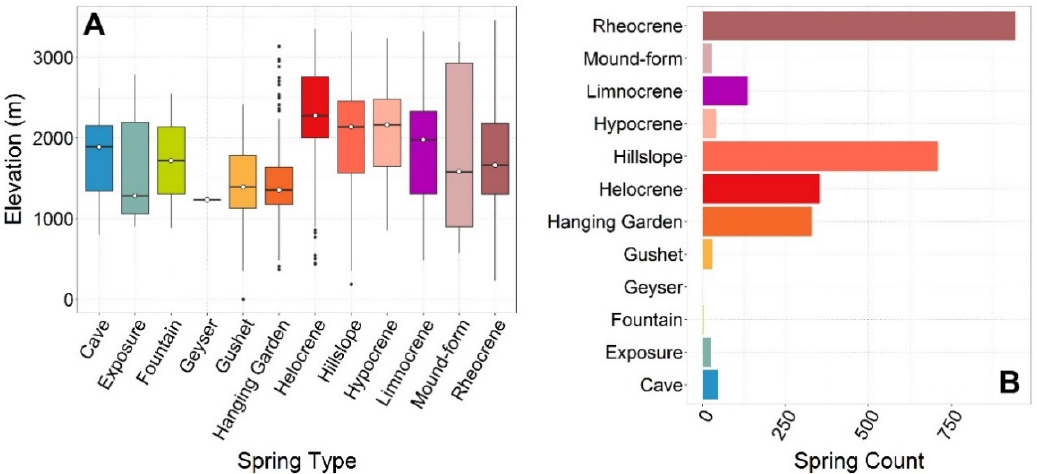
Figure 3. ( A ) Distribution and ( B ) count of springs types across elevation in the Colorado River Basin, calculated on the basis of inventoried springs.